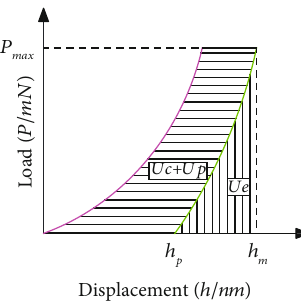
Figure 3: Schematic diagram of total energy and unloading